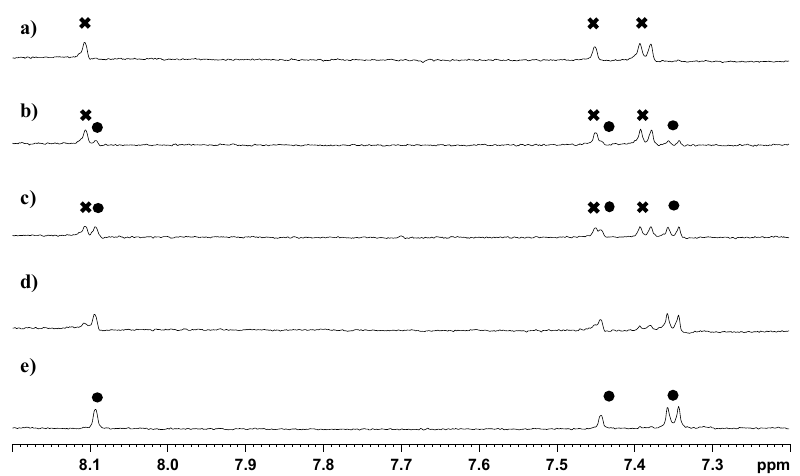
Table 1. Summary of 13 C chemical shifts of 3 in DMSO- d 6 .